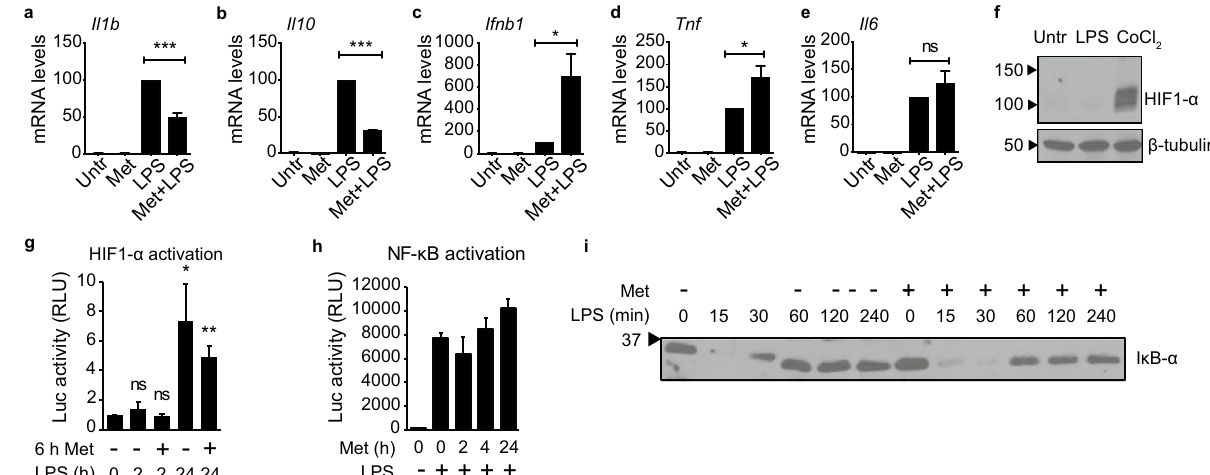
Figure 1. Metformin alters Il1b transcript levels during the acute LPS response independently of IL-10, HIF1-α, and NF-κB. ( a–e ) RT-qPCR with RNA from primary BMDMs, quantifying the indicated genes. Cells were pretreated with 3 mM metformin for 6 h, followed by stimulation with 100 ng/ml LPS for 2 h (Met + LPS). Controls were either left untreated (Untr), treated with metformin but not stimulated (Met), or stimulated with 100 ng/ml LPS for 2 h in the absence of metformin pretreatment (LPS). Tubb5 served as reference gene. Error bars indicate standard error of 5 independent experiments. ( f ) Western blot of lysates from J774 cells treated with 100 ng/ml LPS for 2 h or with 100 μM CoCl 2 for 4 h, probing for HIF1-α and β-tubulin. Black arrows indicate molecular weight in kDa. Images were cropped. See Supplementary Fig. S1f,g for full lanes. ( g,h ) Luciferase assay with RAW 264.7 cells ( g ) transiently transfected with the pGL2-HRE-Luc HIF1-α-dependent luciferase reporter construct or ( h ) stably transfected with the pBIIx-Luc NF-κB-dependent luciferase reporter construct. Cells were ( g ) pretreated or not with 5 mM metformin (Met) for 6 h and then stimulated with 100 ng/ ml LPS for the indicated times up to 24 h, or ( h ) pretreated with 1 mM metformin (Met) for the indicated times up to 24 h and then stimulated or not with 100 ng/ml LPS for 2 h. Luc, luciferase; RLU, relative luminescence units. Error bars indicate standard deviation of ( g ) 5 or ( h ) 3 independent experiments. ( i ) Western blot analysis of IκB-α in lysates of J774 macrophages. Cells were treated with 10 mM metformin for 30 min and stimulated with 100 ng/ml LPS for up to 4 h. Protein concentrations in lysates were quantified and equivalent amounts loaded in each lane. Black arrow indicates molecular weight in kDa. Image was cropped. See Supplementary Fig. S1h for uncropped lanes. p-values: ***p < 0.001; **p < 0.01; *p < 0.05; ns not